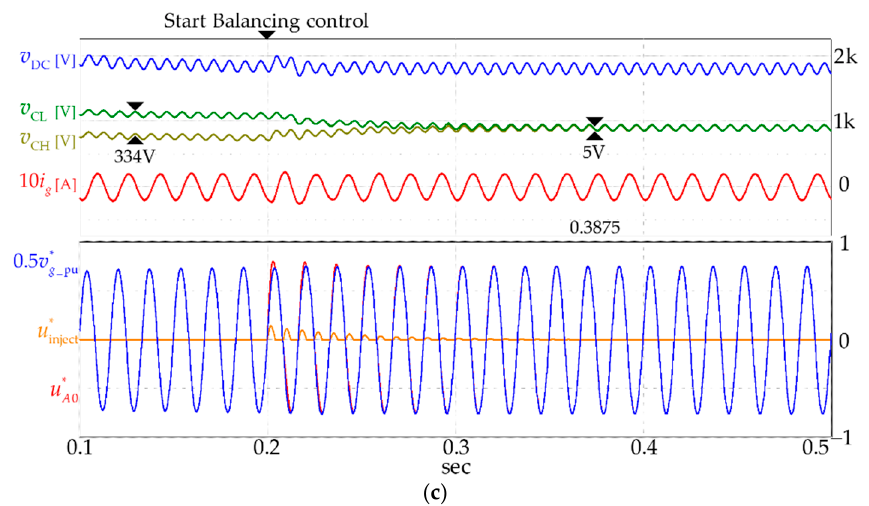
Figure 9. Simulation results for the single-phase NPC inverter with V DC , V CH , V CL and i g : ( a ) using distribution factor μ ; ( b ) using second-order harmonic component; and ( c ) using half-wave of second-order harmonic component.